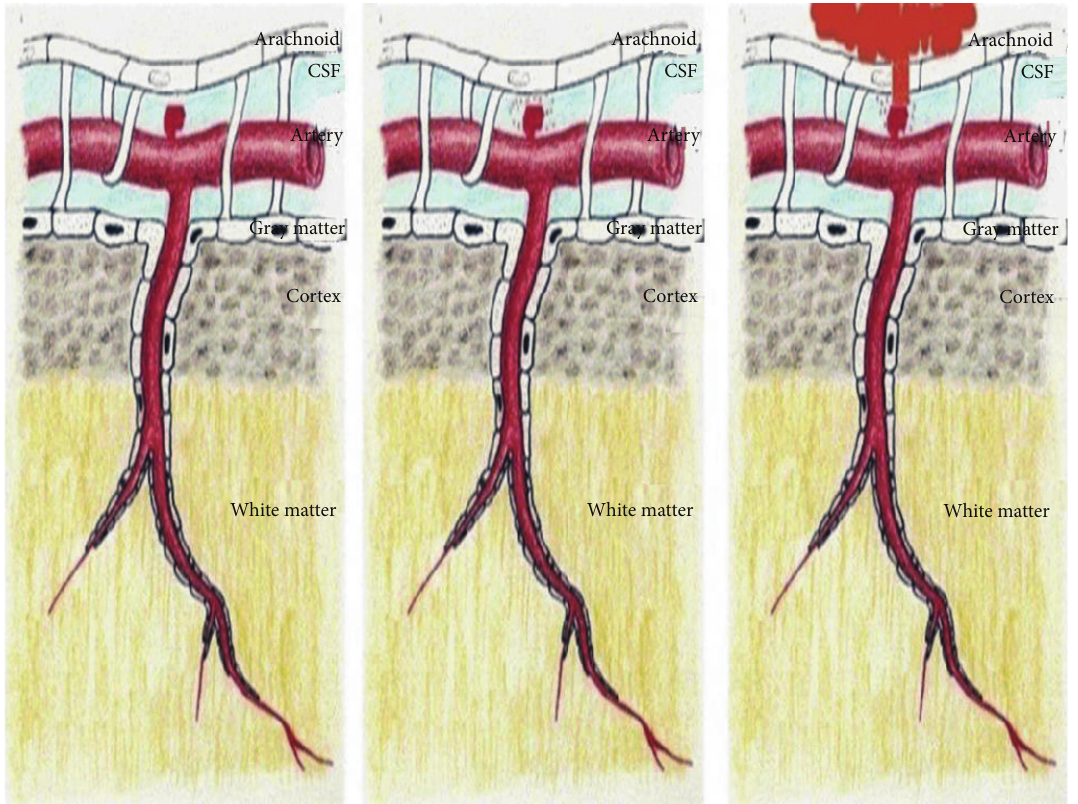
Figure 3: Diagram illustrating the different stages that possibly make an aneurysm bleed in subdural